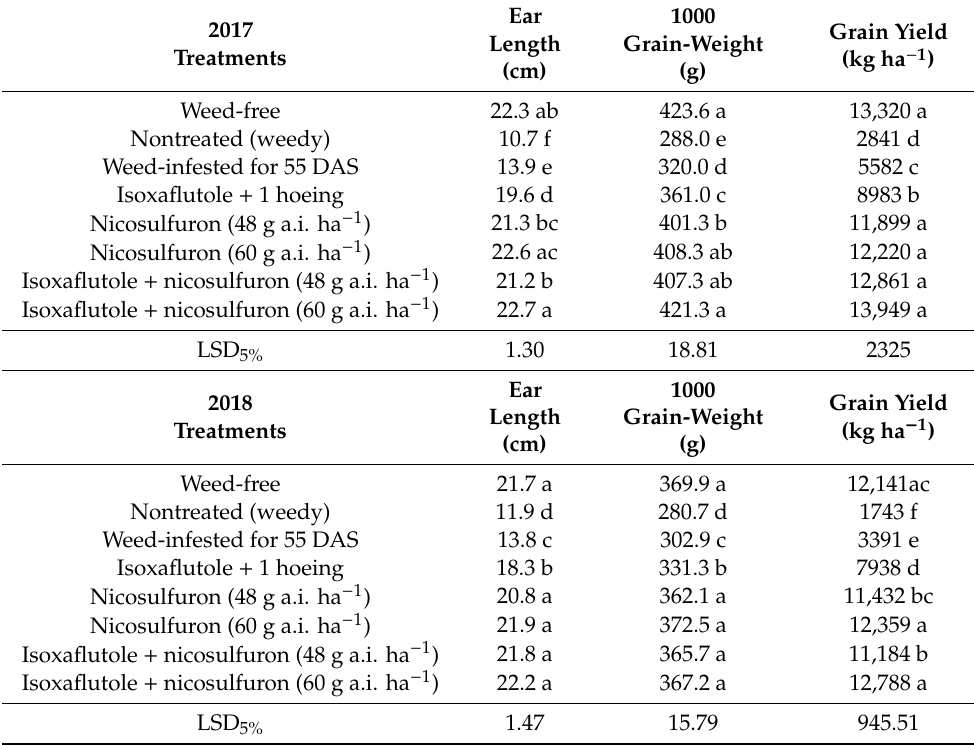
Table 1. Maize grain yield, ear length, and 1000 grain-weight as a ff ected by the various treatments at the harvest stage, in 2017 and 2018 (Velestino, Greece). Means followed by di ff erent letters indicate significant di ff erences according to Fisher’s Least Significant Di ff erence (LSD) test ( p < 0.05).